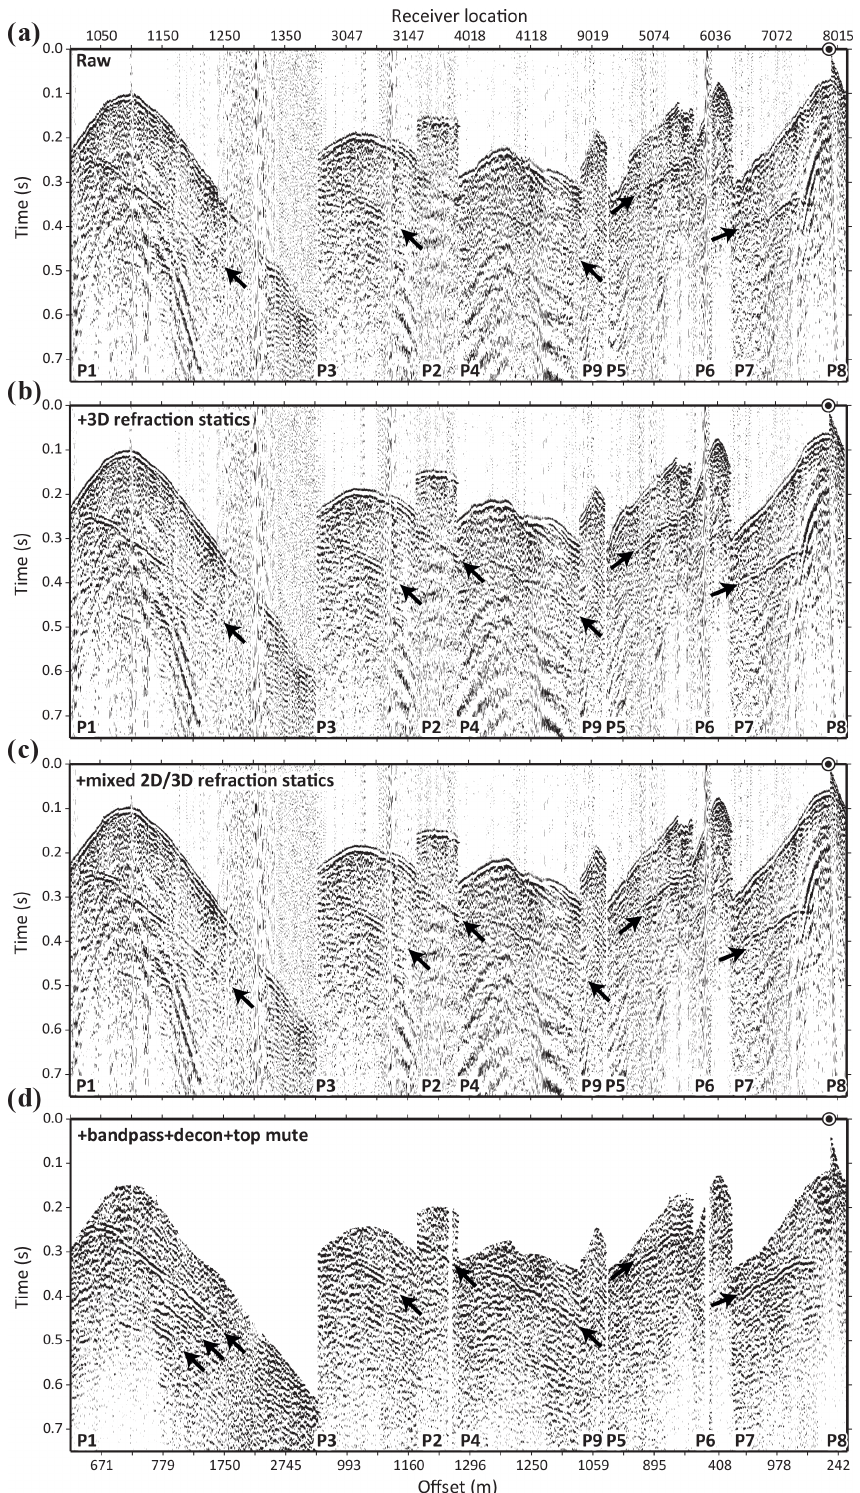
Figure 7. (a) An example of raw shot gather along P8 after (b) 3D static corrections; (c) mixed 2D and 3D static corrections (used for processing); and (d) bandpass filter, deconvolution (zero-phase or spectral whitening), and top mute. Note the increase in the signal quality and especially the coherency of the reflections marked using the arrows (we expect these to be from the mineralization from the earlier 2D surveys and downhole logging